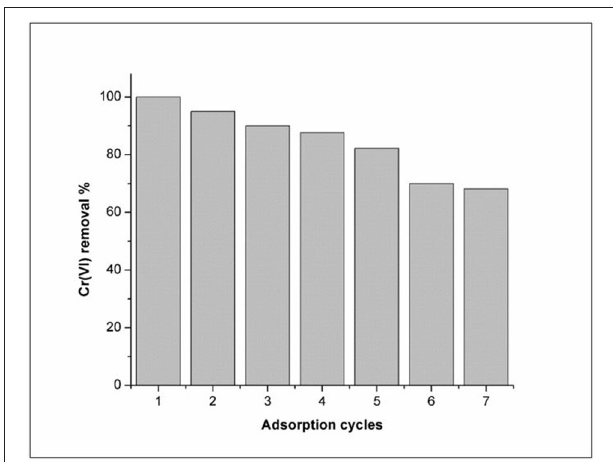
FIGURE 11 | Reusability of the adsorbent (Fe 3 O 4 /FMO).